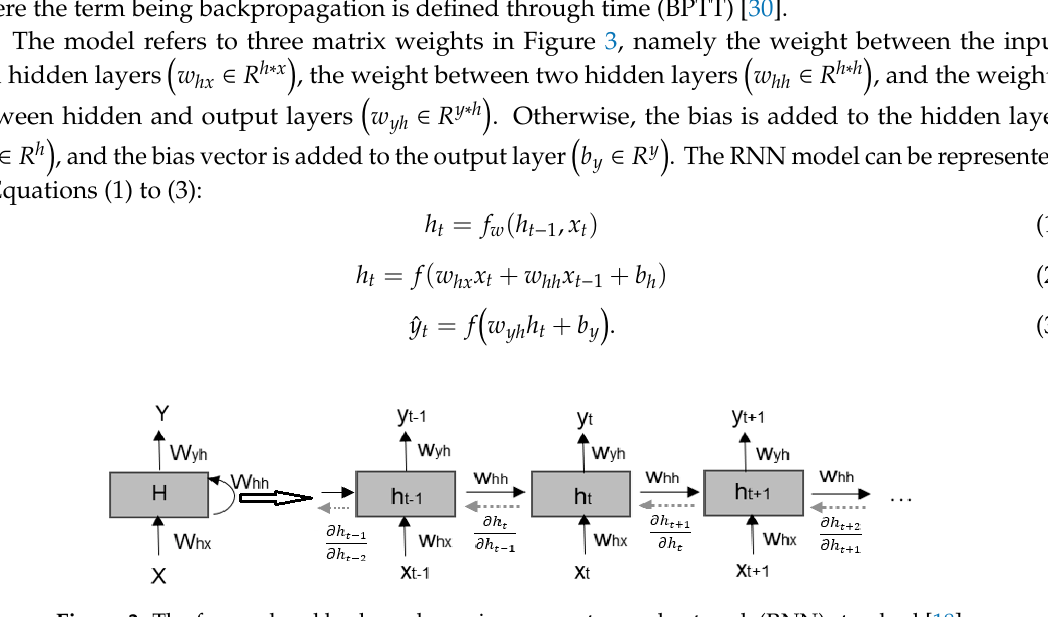
Figure 3. The forward and backward pass in recurrent neural network (RNN) standard [18]